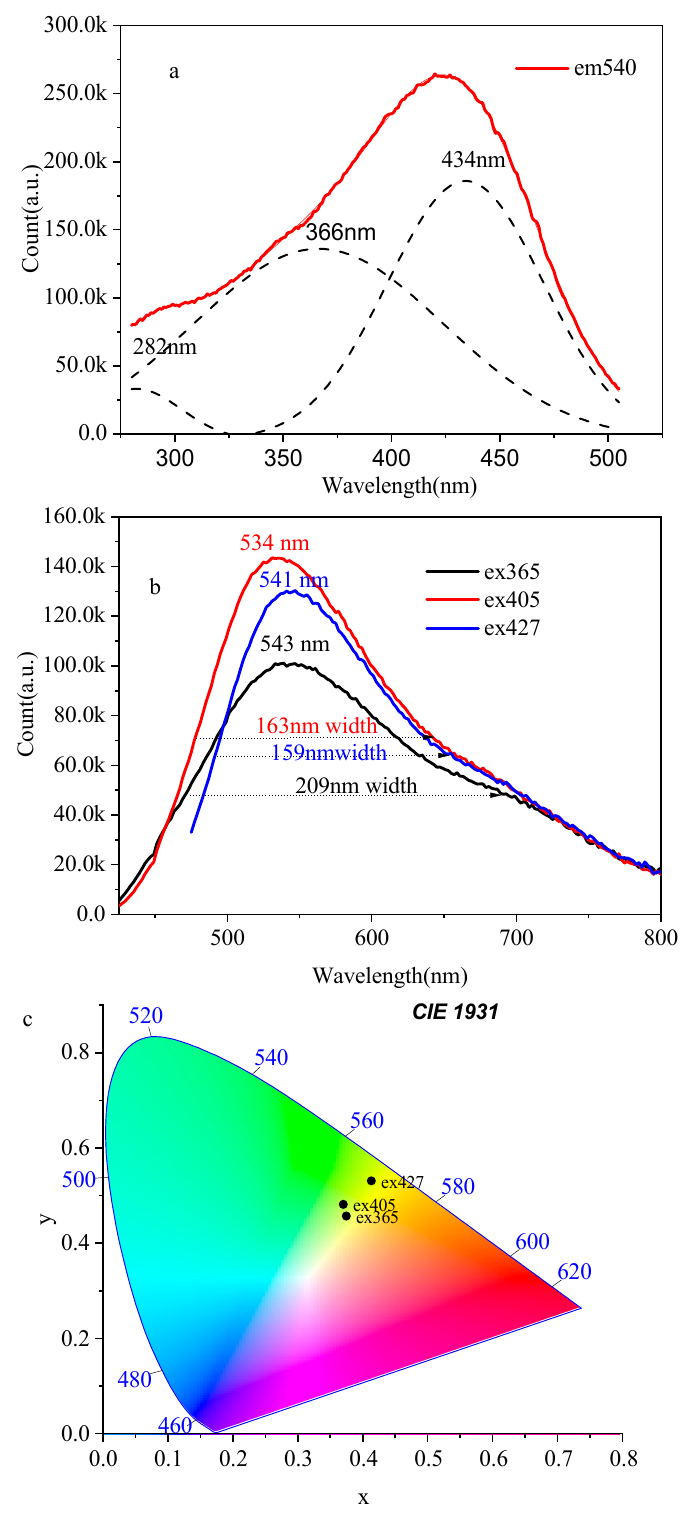
Figure 3. Excitation and emission spectra of Yb 2+ -doped silica glass. ( a ) Excitation spectrum with an emission wavelength of 540 nm; ( b ) emission spectra with excitation wavelengths of 365, 405 and 427 nm; ( c ) chromaticity diagram for various excited wavelengths.